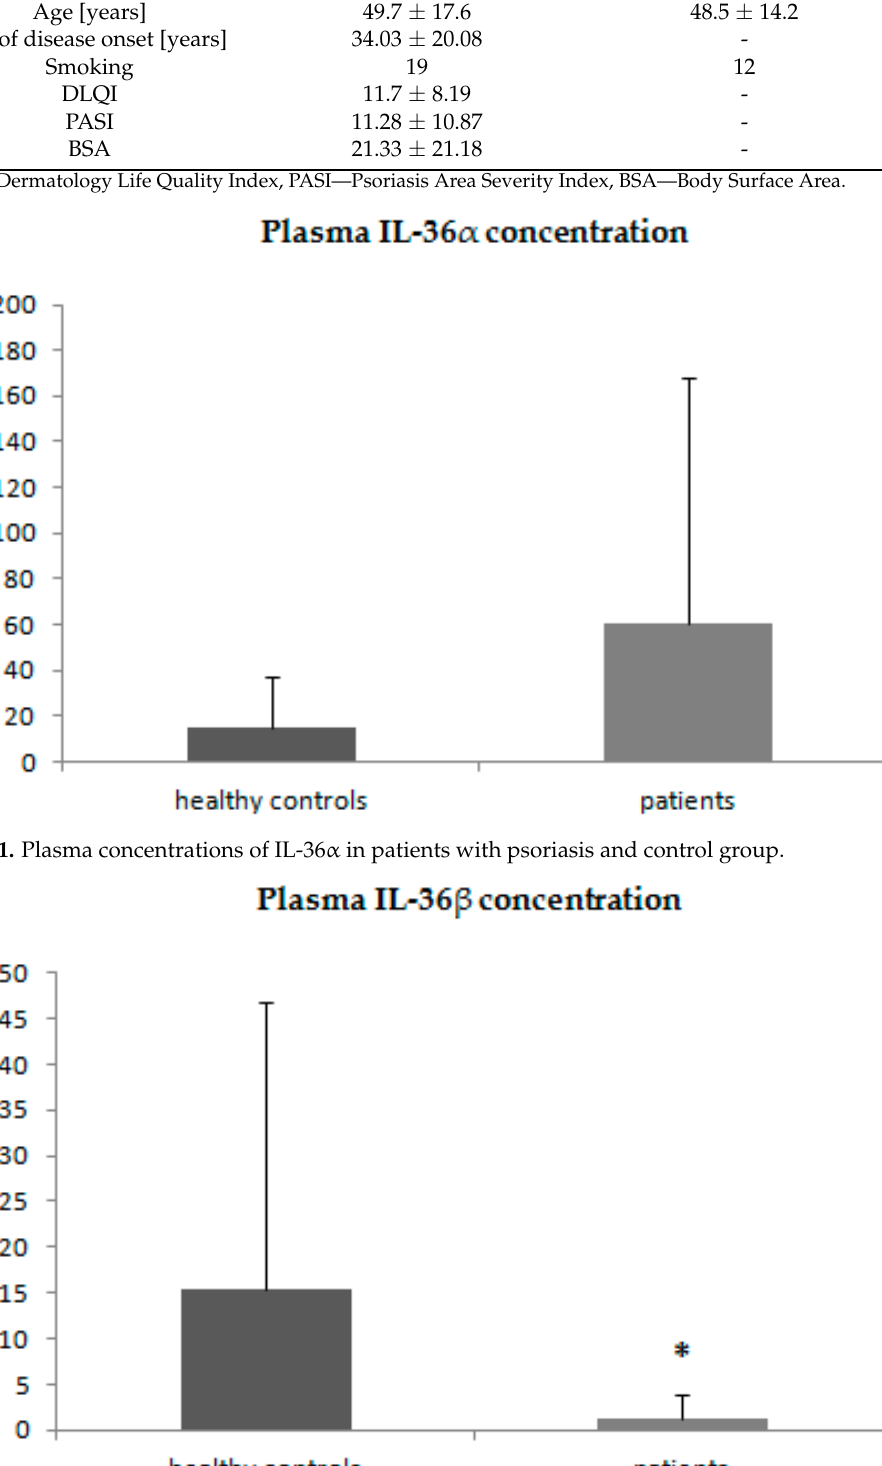
Figure 3. Plasma concentrations of IL ‐ 37 in patients with psoriasis and control group. * p < 0.001. Additionally, we compared the plasma concentrations of IL ‐ 36 α , IL ‐ 36 β , and IL ‐ 37 between men and women with psoriasis. These differences were not statistically signifi ‐ cant ( p = 0.45, p = 0.15, and p = 0.1, respectively). We also compared the plasma concentrations of IL ‐ 36 α , IL ‐ 36 β , and IL ‐ 37 between smoking and non ‐ smoking patients. These differences were not statistically significant (p = 0.37, p = 0.87, and p = 0.6, respectively). 3.2. Correlations between Plasma Concentrations of IL ‐ 36 α , IL ‐ 36 β , and IL ‐ 37 and Clinical Parameters in Patients with Psoriasis The next point of our study was to examine the correlations between plasma con ‐ centrations of IL ‐ 36 α , IL ‐ 36 β , and IL ‐ 37 and clinical parameters.